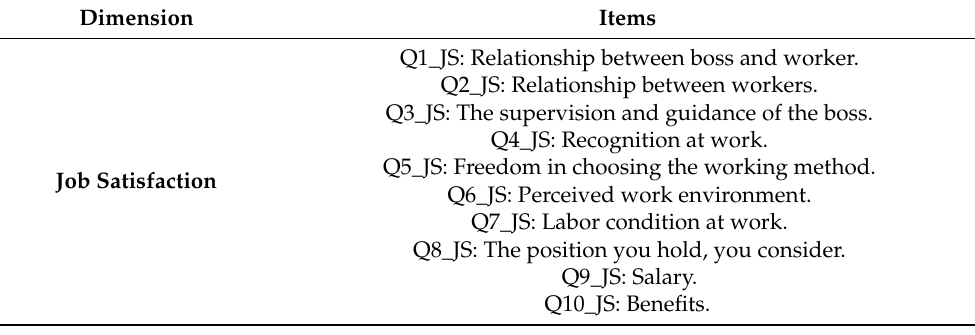
Table 7. Constructs of job satisfaction.